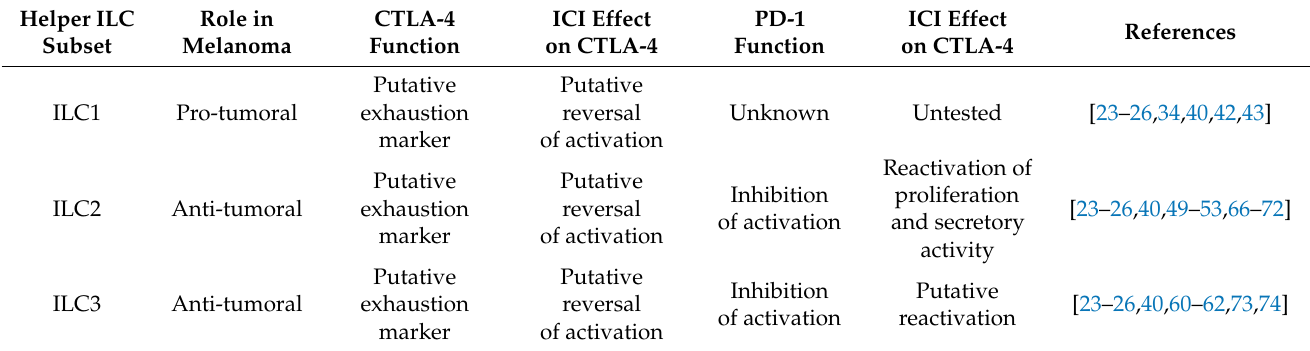
Table 1. Helper ILCs in melanoma. The table summarizes the current knowledge about the role of the different helper ILC subpopulations in melanoma and how they are affected by